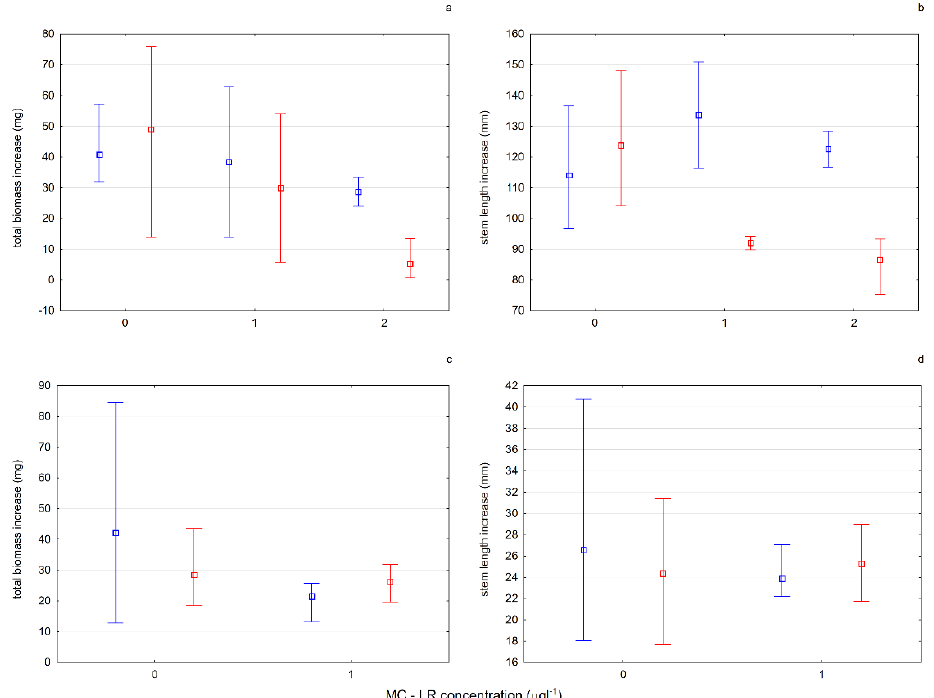
Figure 9. The effect of different concentrations of MC-LR on the biomass increase and the growth of the shoots from plants ( a , b ) or from turions ( c , d ). Plants from the natural site in Lake Łukie are marked in blue and those from Lake Długie in red. Whiskers indicate the range of values, and squares indicate the mean.